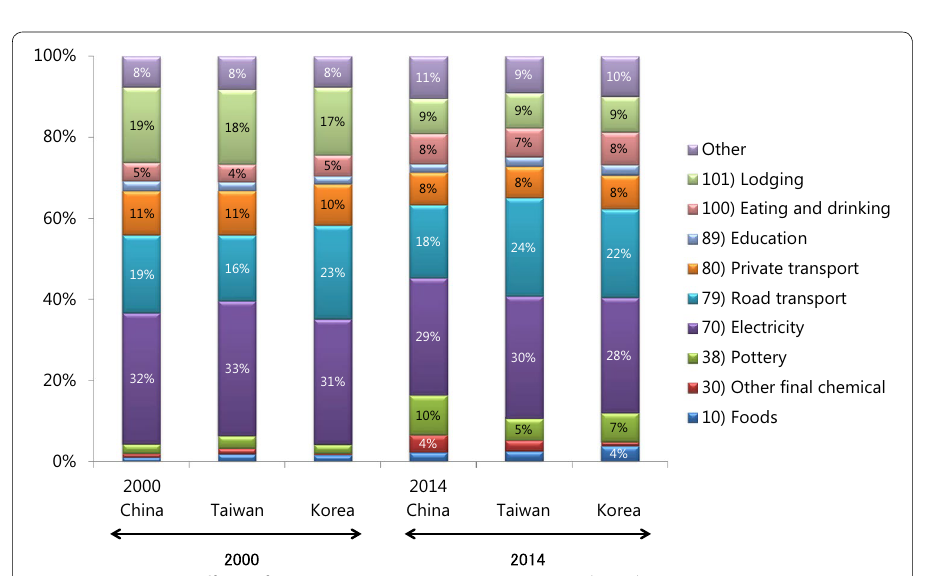
in light blue and orange bars, “101) Lodging” shown in light green bars, “100) Eating and drinking,” shown in pink bars, and “38) Pottery” in green bars. Thus, it can be seen that